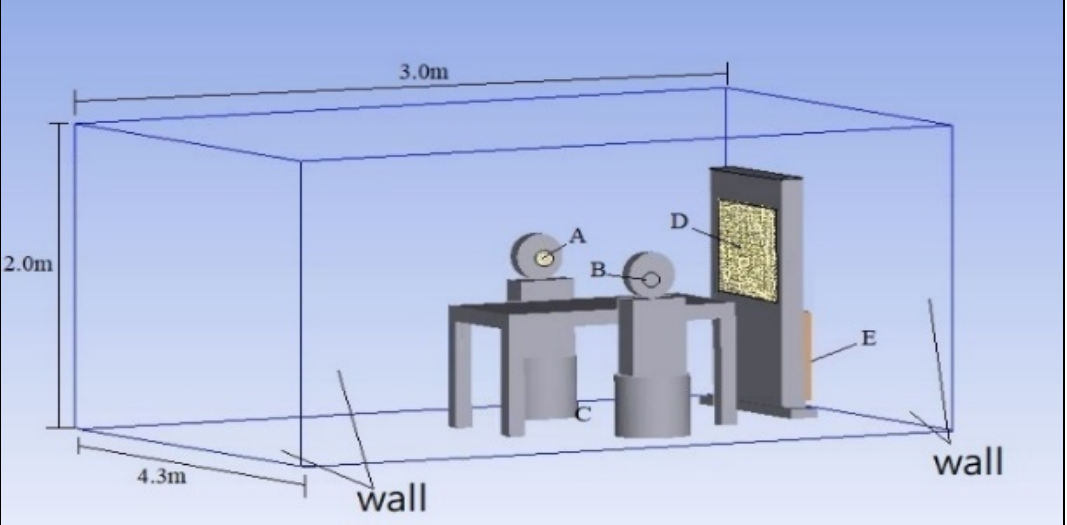
Figure 4. Air purifier in the consulting room.